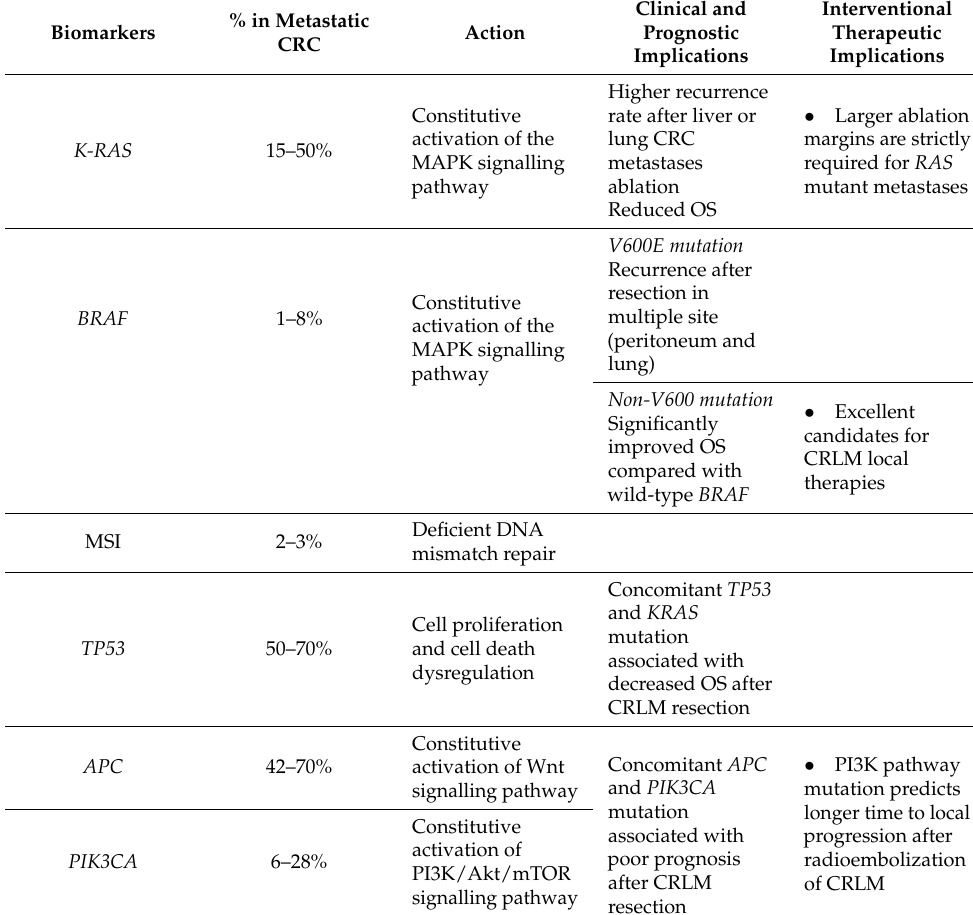
Table 2. Principal molecular biomarkers with their implications in interventional